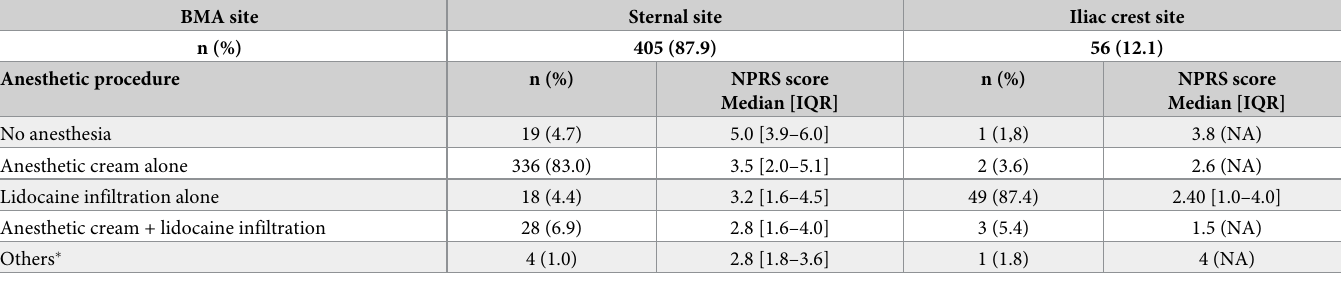
Table 2. NPRS scores according to the site and the anesthetic